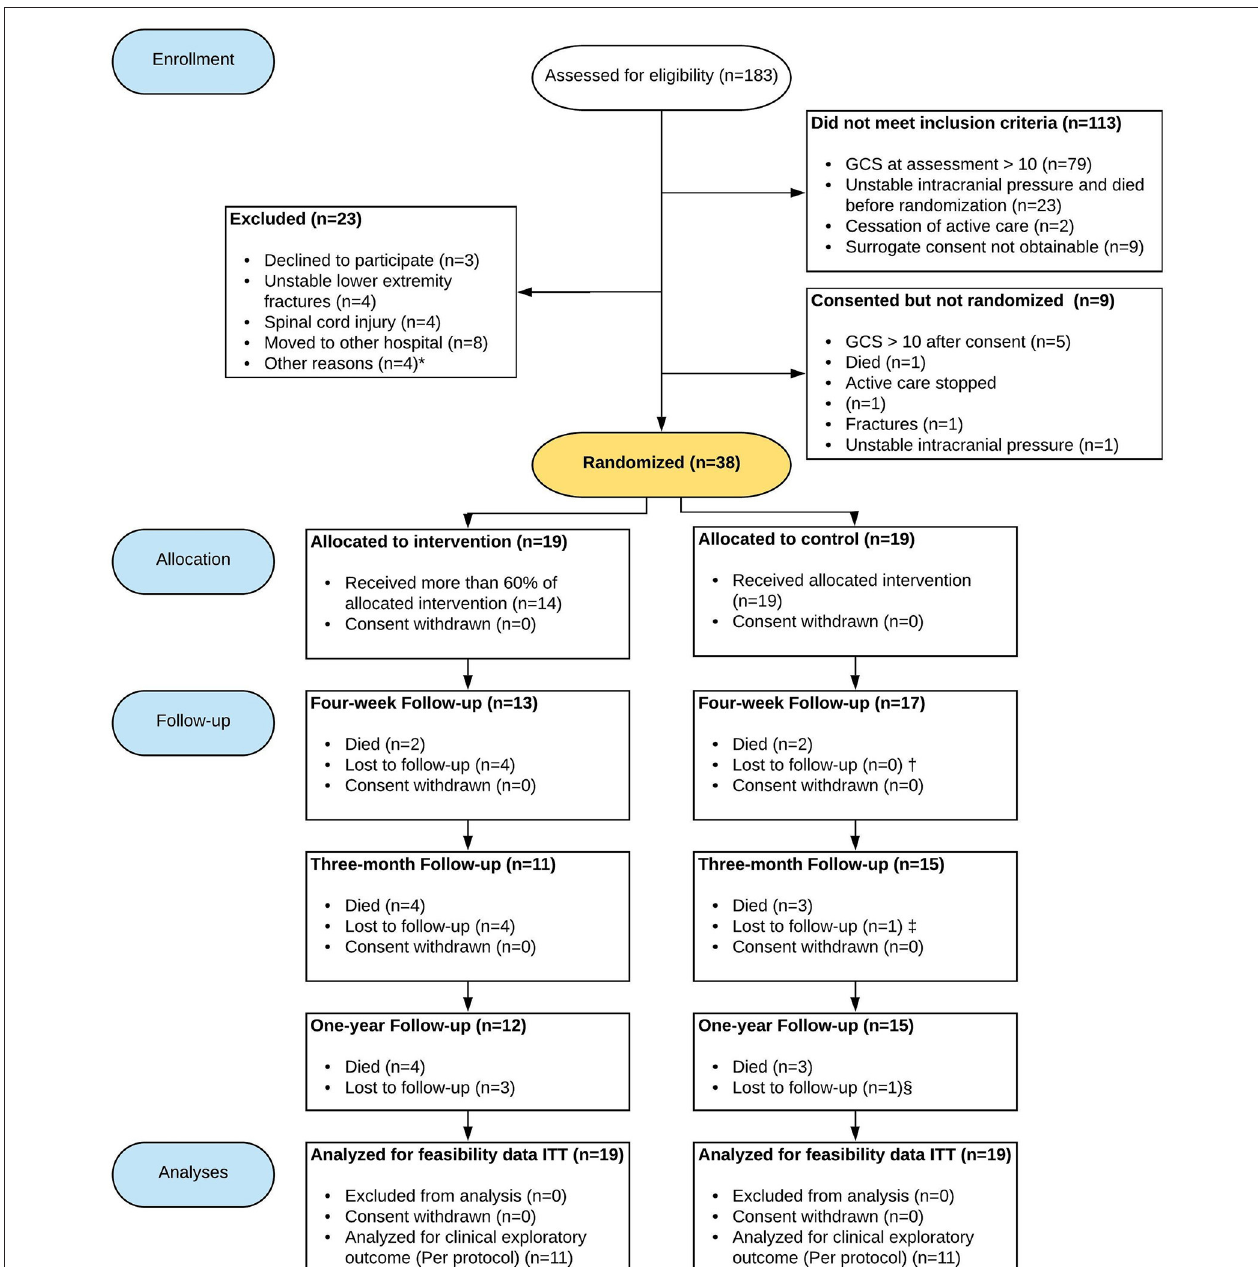
FIGURE 1 | Flow of patients through the trial. GCS, Glasgow coma score; ITT, Intention to treat. *Other reasons include: High frequency of dialysis, waiting for a pacemaker, body weight exceeding the limit of the mobilization device; † Coma Recovery Scale-Revised ( n = 16) one patient discharged before the test; ‡ Early discharge from the rehabilitation department before assessments ( n = 1); § In the intervention group one patient was not assessed with Coma Recovery Scale-Revised and Early Functional Ability and in the standard care group one patient was not assessed with Coma Recovery Scale-Revised. Due to the nature of the Glasgow Outcome Scale Extended (where 1 equals death), all participants were scored in the standard care group. In the intervention group, three were lost to follow-up.